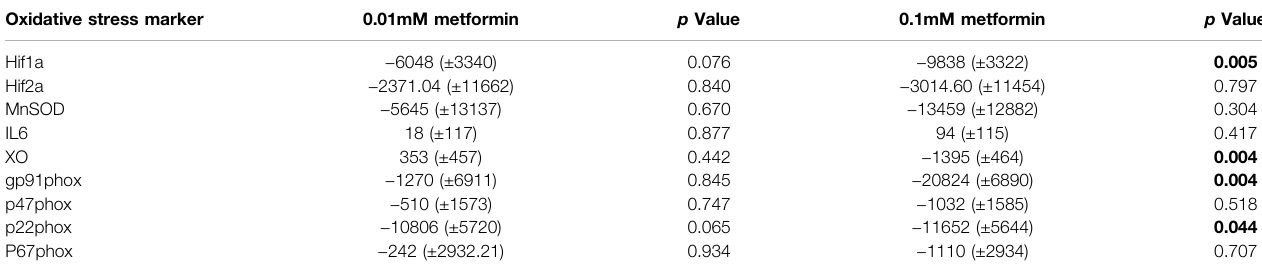
The p values listed in bold refer to p values that reached the pre-speci fi ed threshold for signi fi cance ( < 0.05) (i.e., Hif1a; 0.005, XO; 0.004, gp91phox; 0.004 and p22phox; 0.0440).